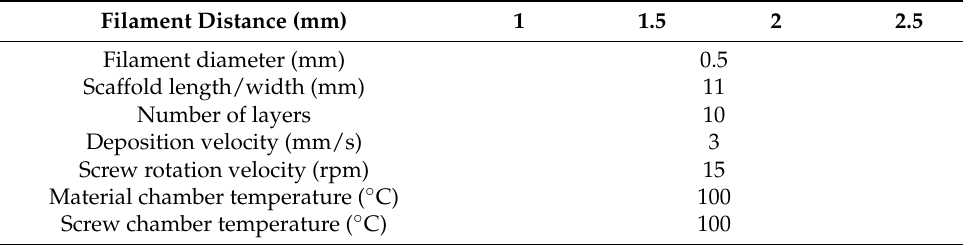
Figure 4. Plasma-assisted bio-extrusion system (PABS) setup. Table 1. Printing parameters .